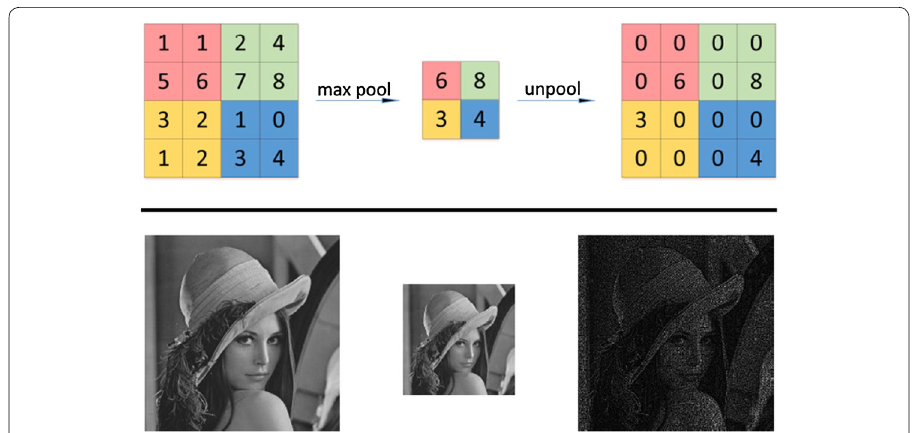
Fig. 4 Top: max pooling and unpooling in theory. Bottom: max pooling and unpooling in